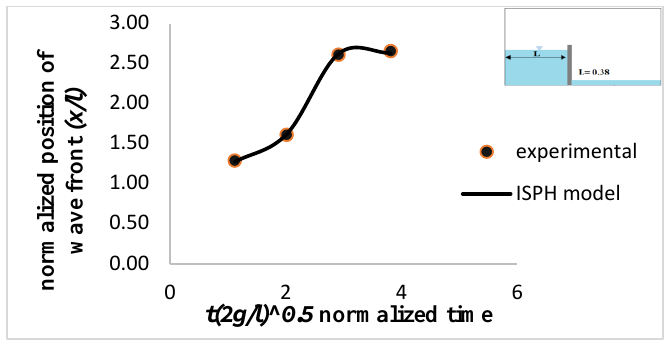
Figure 9 Comparison of numerical and experimental normalized diagram of the position of the wave front for gradually collapse of water column case. TABLE 2 Evaluation of the ISPH numerical model via relative error statistic of the position of the wave front for gradually collapse of water column test case. Relative error of Relative error of Time (s) Wave height % Wave position %